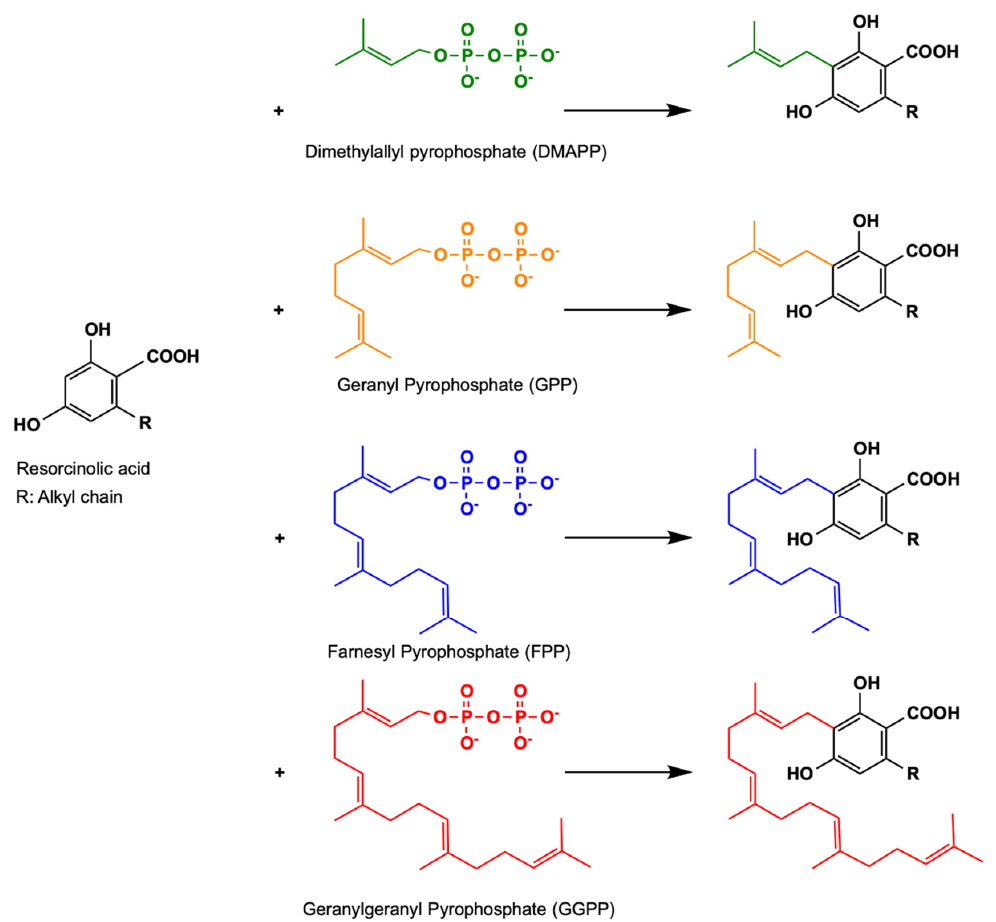
Figure 9. Potential cannabinoid products biosynthesized using an OLA resorcinolic acid scaffold as prenyl acceptor with different prenyl donors.